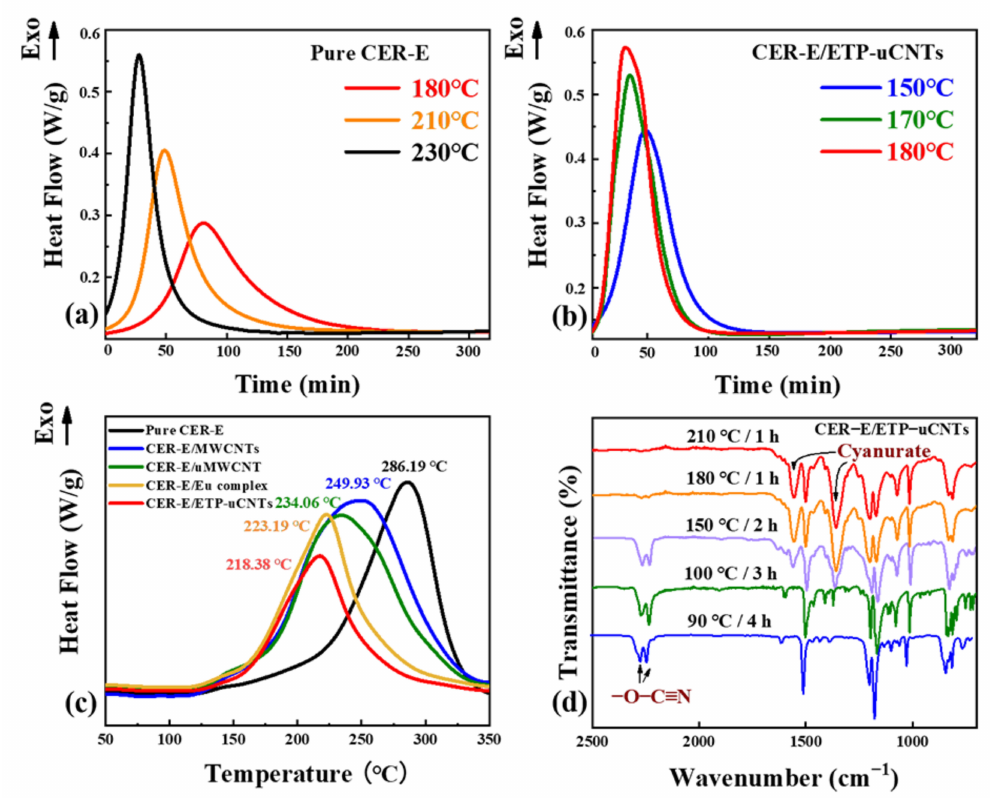
Figure 3. DSC thermograms of CER-E curing process ( a – c ) and FTIR spectra ( d ) of pure CER-E and CER-E hybrid nanocomposites.